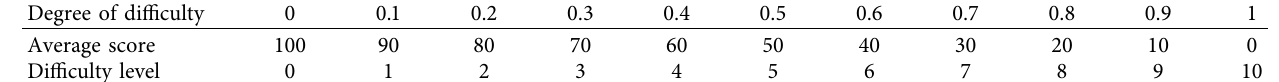
Table 1: The relationship between the degree of difficulty and the level of difficulty.